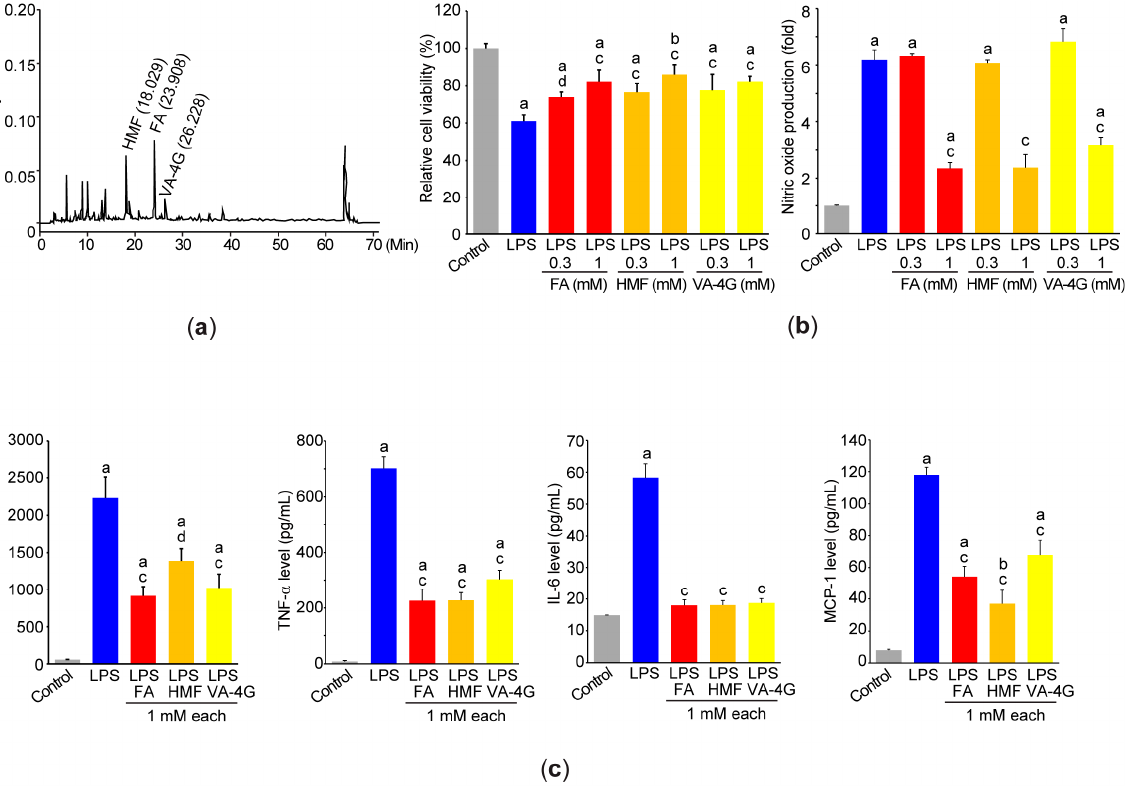
Figure 8. FA, HMF, and VA-4G are bioactive compounds responsible for the anti-inflammatory effect of AsE. ( a ) Representative HPLC chromatogram of AsE. Eluants were monitored at 254 nm, and the numbers in the chromatogram are retention times of each bioactive compound. ( b ) Effect of three bioactive compounds on nitric oxide production. Raw264.7 cells were pretreated with 0.3 and 1 mM of three bioactive compounds for 1 h, and subsequently exposed to the LPS for 18 h. Viable cells were determined by an MTT assay ( left ), and nitric oxide was measured by incubating conditioned medium with the Griess reagent ( right ). ( c ) Effect of three bioactive compounds on proinflammatory mediator production. Levels of proinflammatory mediators in conditioned medium were determined using commercial ELISA kits. a p < 0.01, b p < 0.05 versus control cells; c p < 0.01, d p < 0.01 versus LPS-treated cells; FA, 2-furoic acid; HMF, 5-hydroxymethyl furfural; HPLC, high-performance